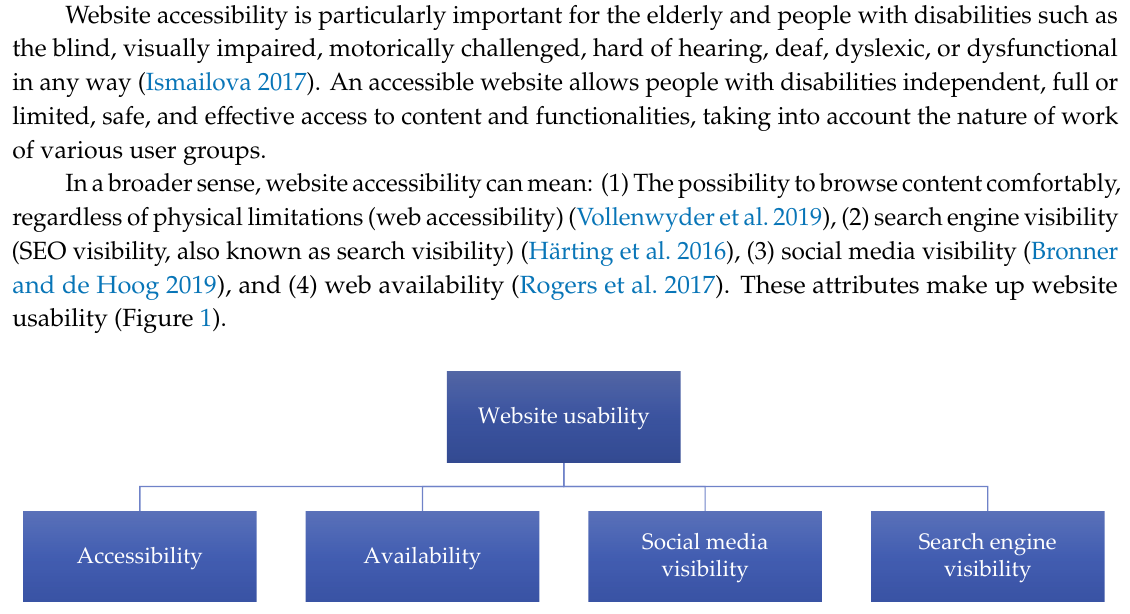
Figure 1. Ways website accessibility can be perceived. Source: Own work.